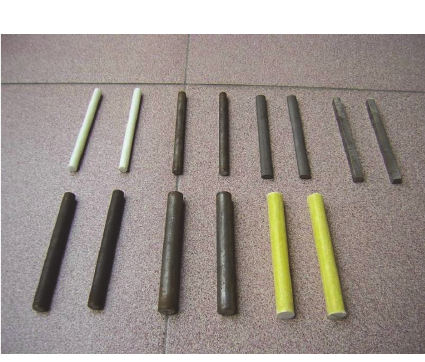
Figure 2: Dowel bars with different materials and shapes.